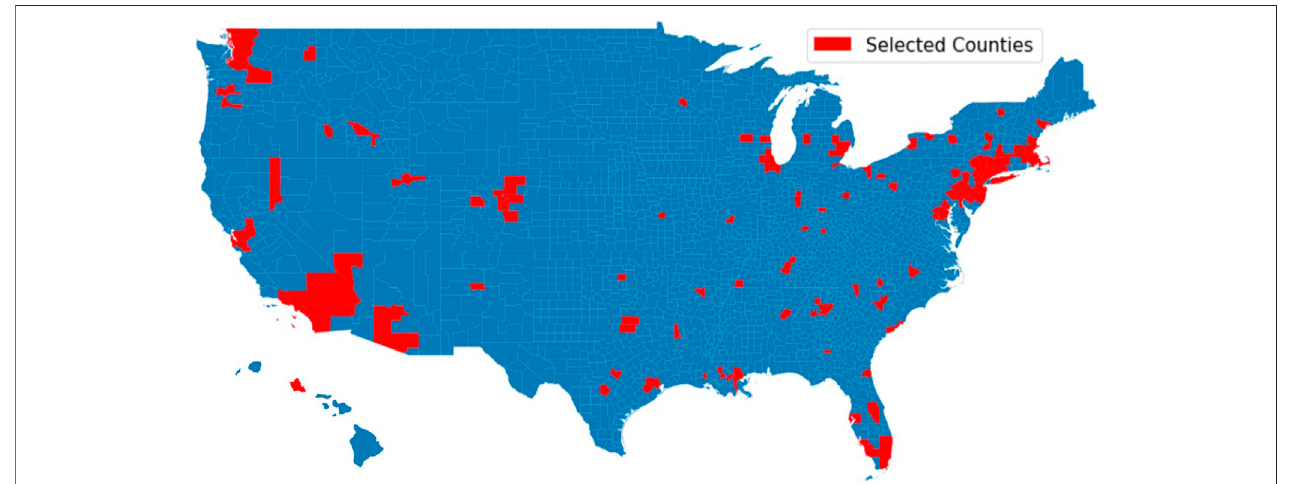
FIGURE 1 | 193 selected counties whose cumulative con fi rmed cases were greater than 100 as of March 31, 2020.